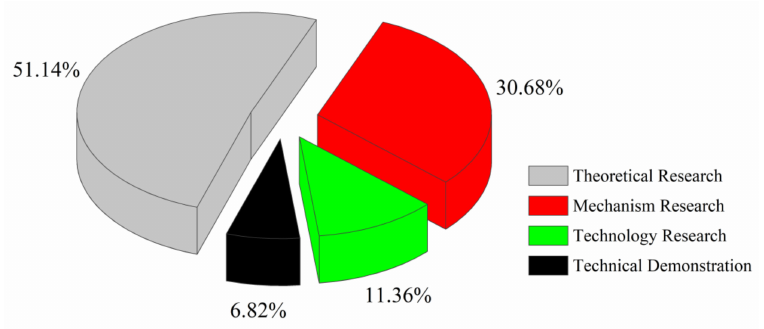
Figure 4. Classification of literature contents, as expressed in